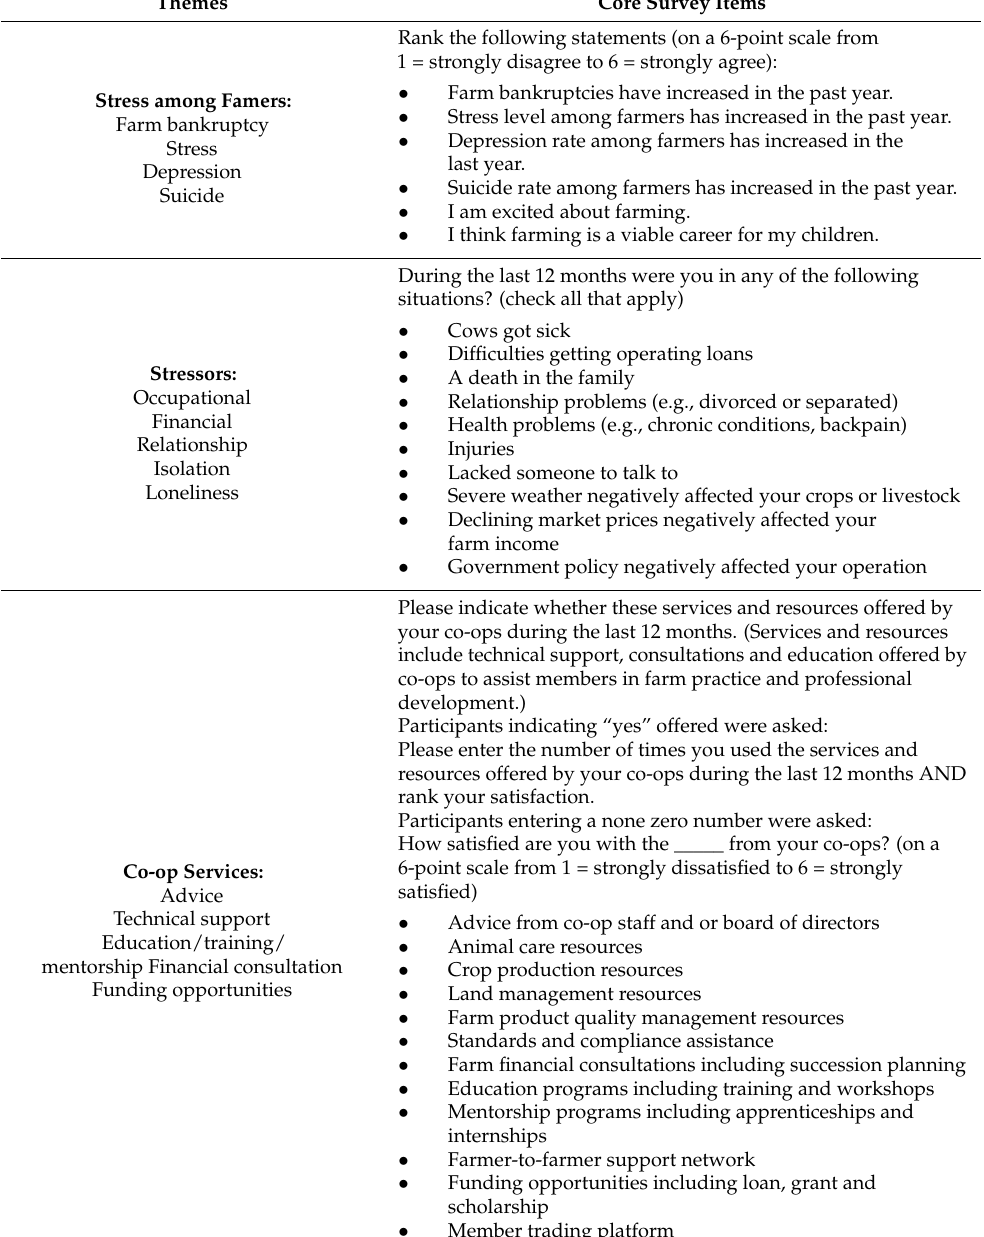
Table A1. Core survey items organized by